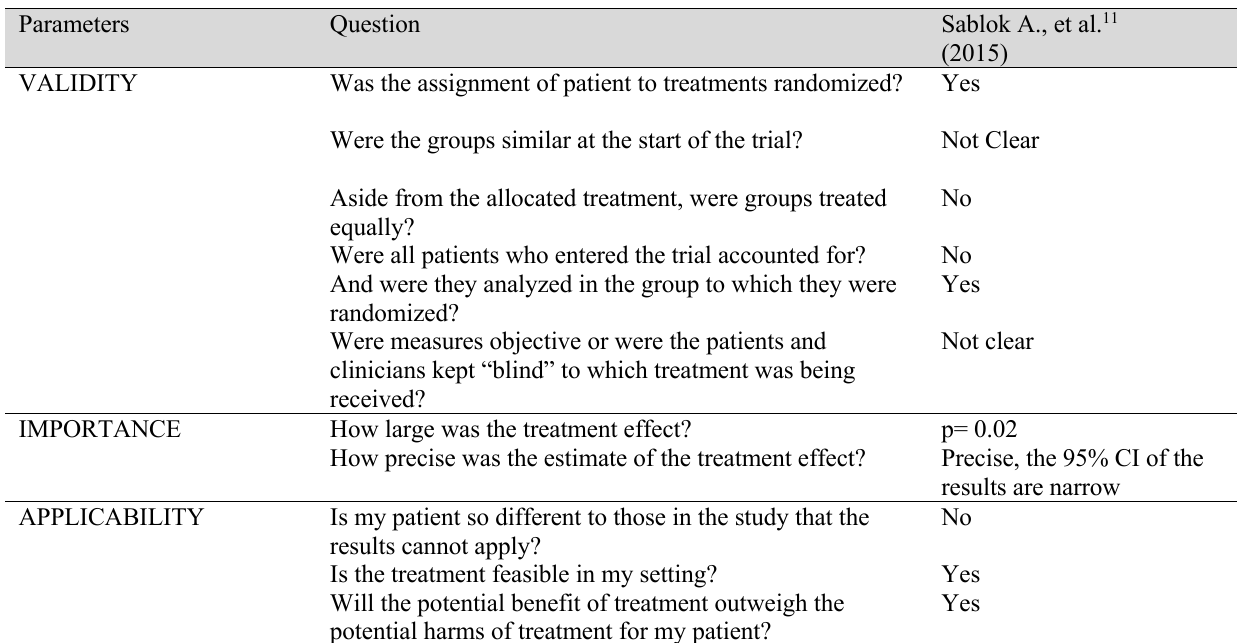
Table 3 . Critical appraisal of the RCT study Parameters